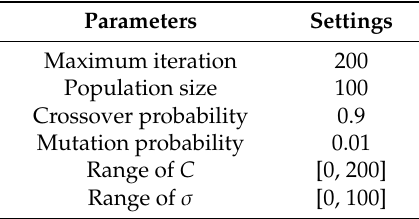
Table 2. Parameter settings of